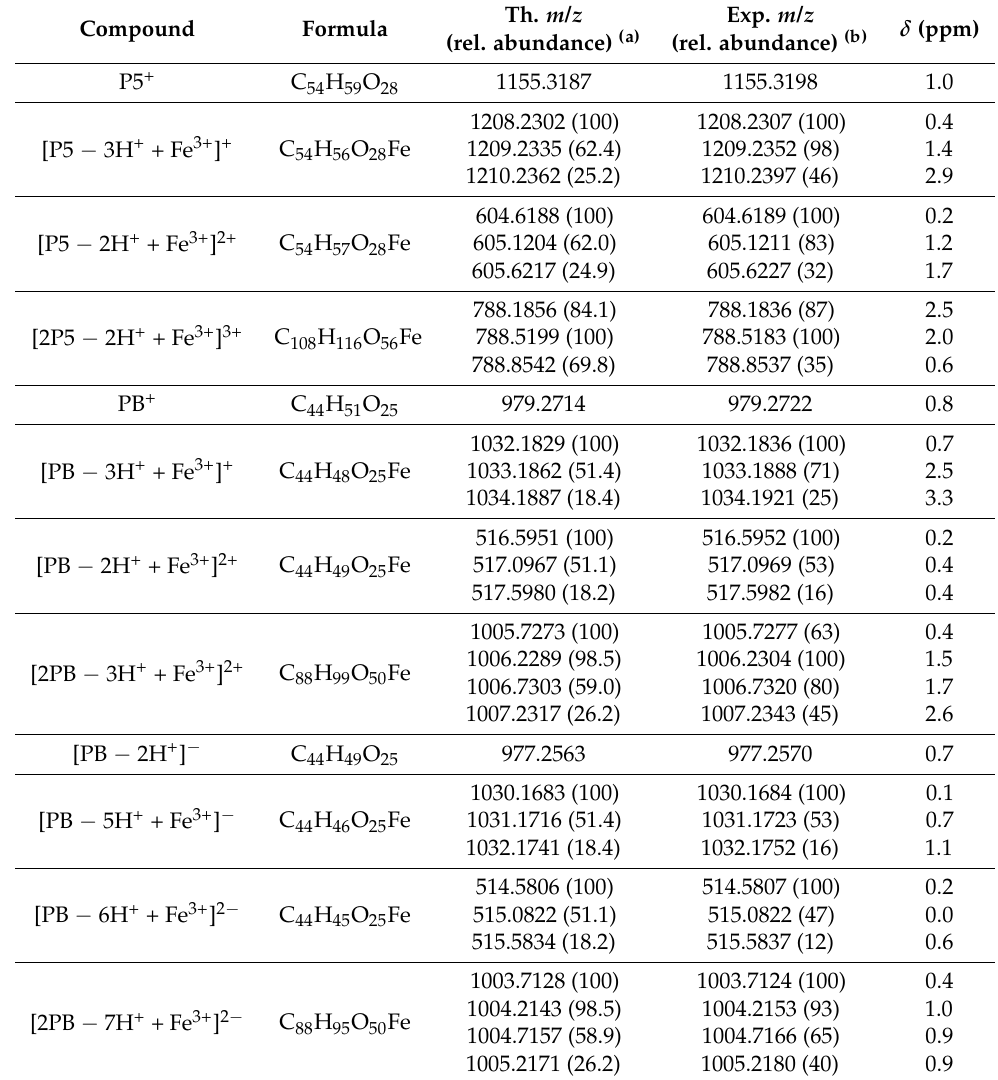
Table 2. Ions detected for the iron complexes of pigments P5 = Cya-3-(Fl)Glc-2-(Sp)Glc-3-Glc